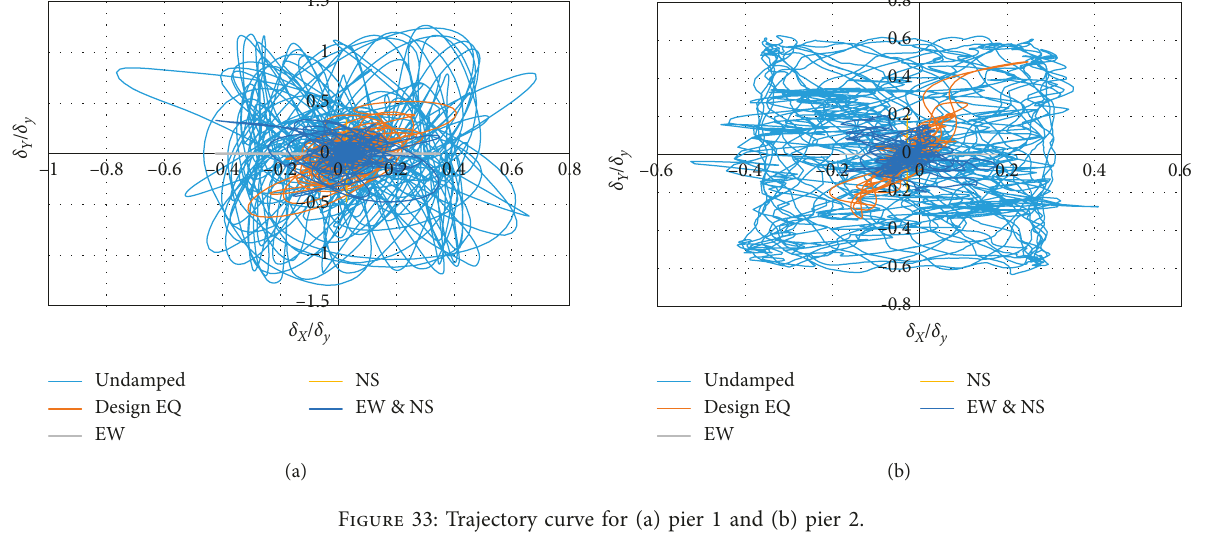
Figure 33: Trajectory curve for (a) pier 1 and (b) pier 2.